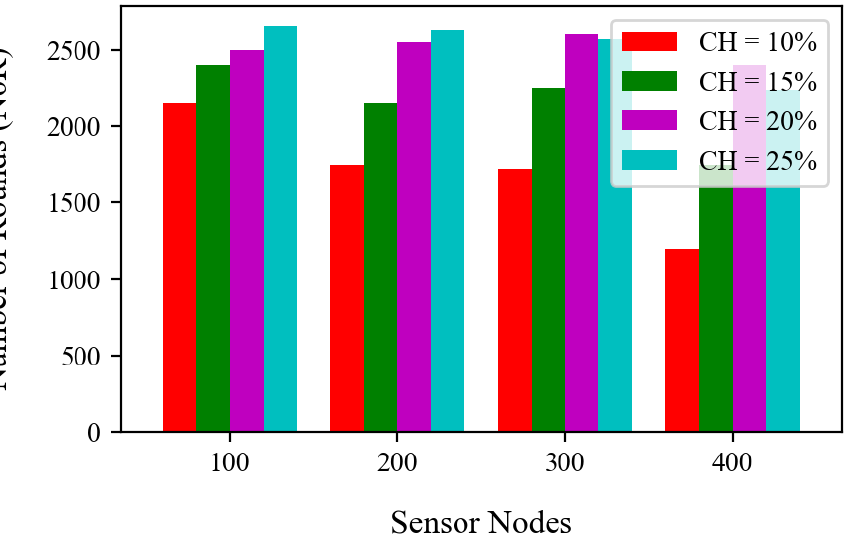
Figure 8. Impact of NCHs on the network lifetime.